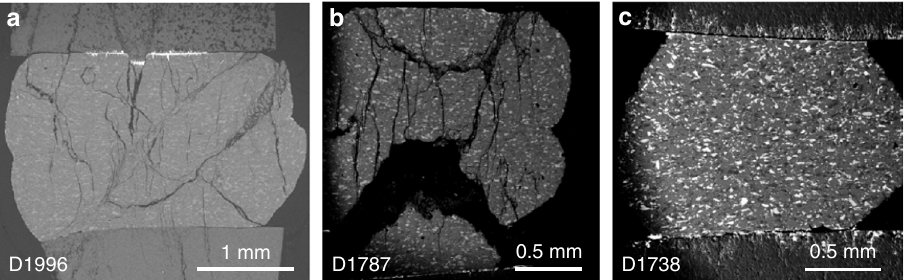
Fig. 5 Low-magni fi cation SEM images showing microstructure samples deformed under various conditions. a D1996 (G sample, 1073 K, to 40% strain). b D1787 (EG sample, 1073 K, to 30% strain). c D1738 (EG sample, 1273 K, to 30% strain. Both 1073 K samples contain through-going faults ( a , b ), whereas the 1273 K sample has no visible faults at this magni fi